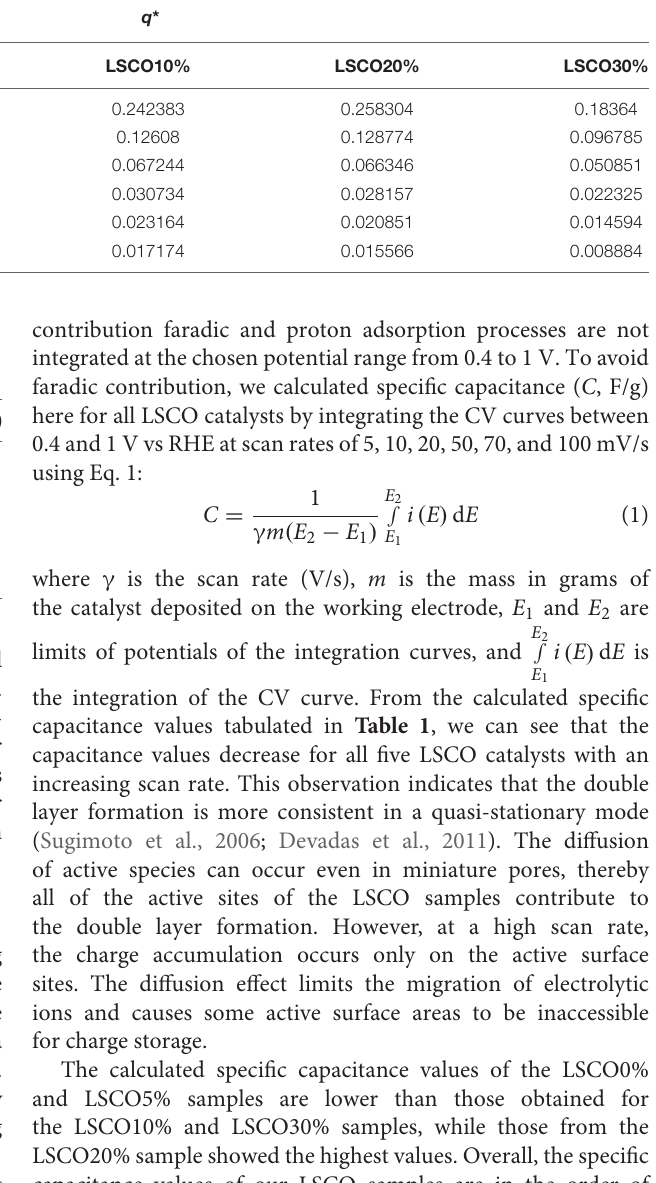
TABLE 2 | Voltammetry charges ( q *) of the LSCO0%, LSCO5%, LSCO10%, LSCO20%, and LSCO30% samples at scan rates of 5, 10, 20, 50, 70, and 100 mV/s. Scan rate (mV/s)